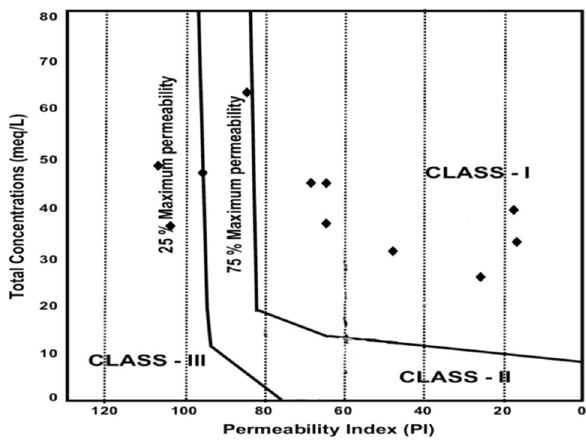
Fig. 3 Doneen diagram representing Ajali River water quality for irri- gation application